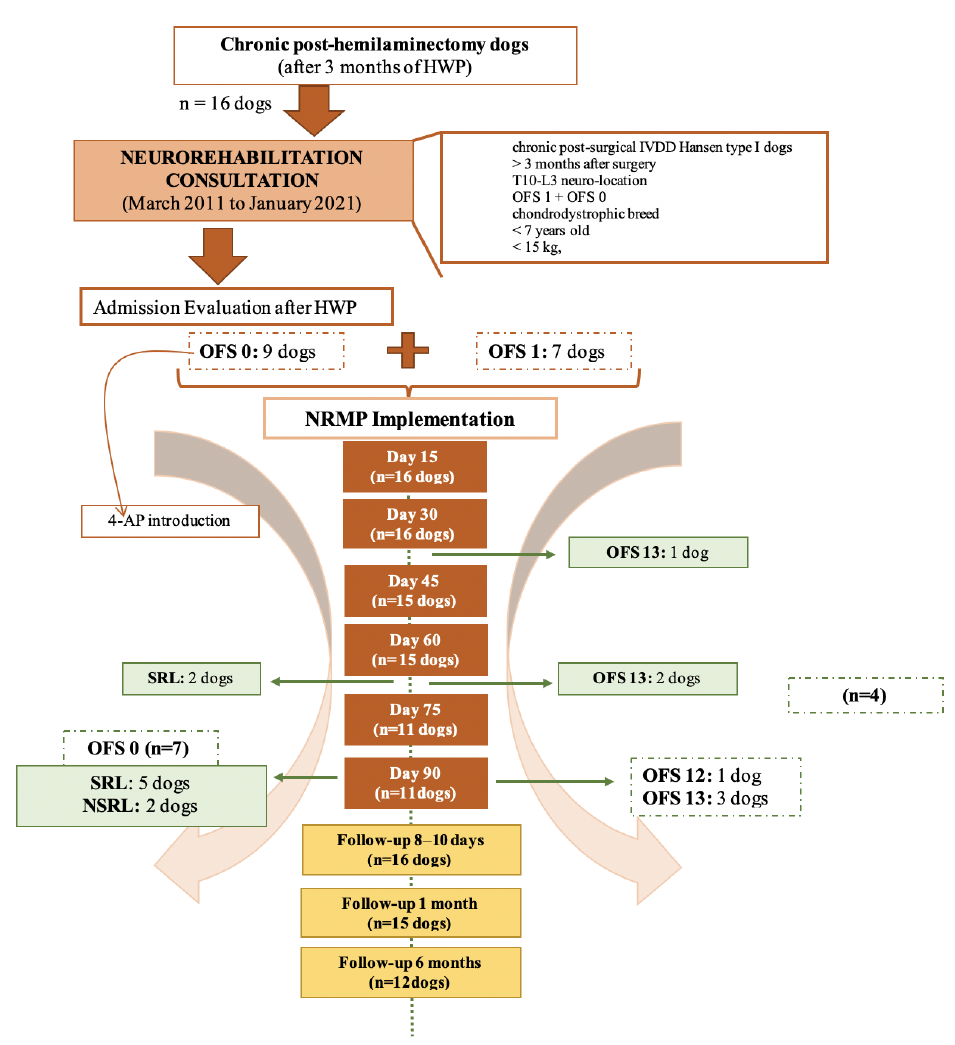
Figure 4. Flow diagram illustrating chronic paraplegic post-hemilaminectomy dogs’ evolution and medical discharge. Abbreviations: OFS—open field score [64]; NRMP—neurorehabilitation multimodal protocol; HWP—Home Work Plan; SRL—Spinal Reflex Locomotion; NSRL—Non-Spinal Reflex Locomotion.